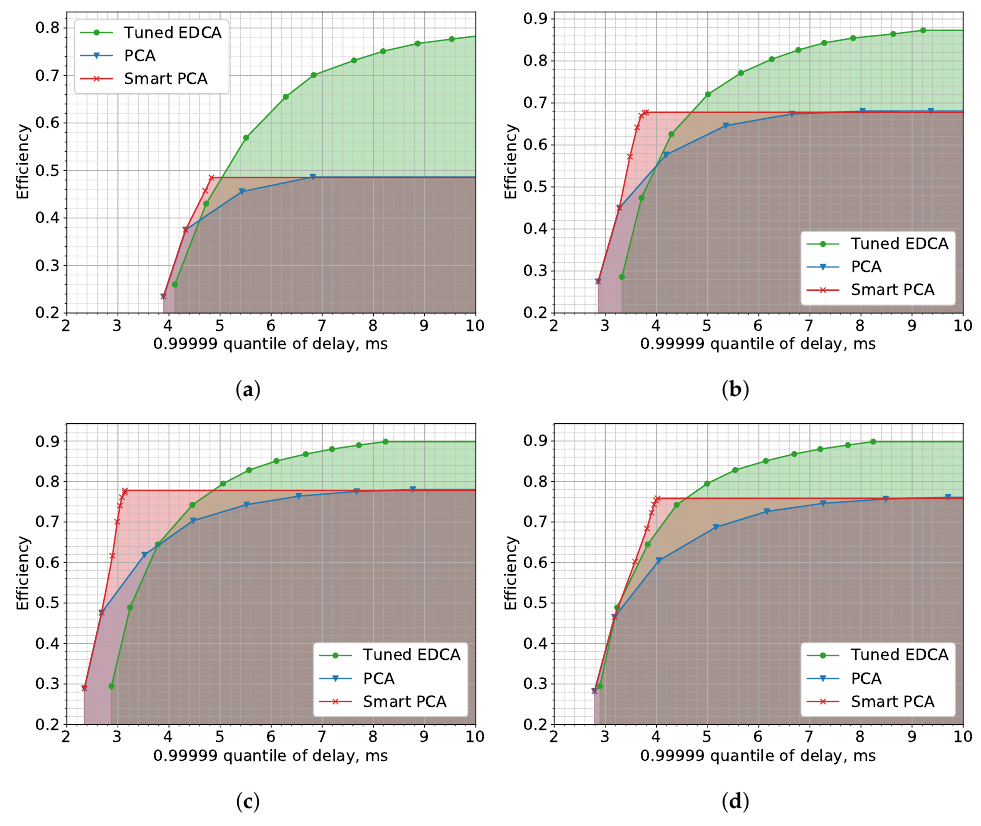
Figure 6. Dependences of the maximum efficiency on the provided delay quantile (part I). ( a ) T period = 20ms, σ = 10µs, M = 5. ( b ) T period = 50ms, σ = 10µs, M = 5. ( c ) T period = 100ms, σ = 10µs, M = 5. ( d ) T period = 100ms, σ = 100µs, M =